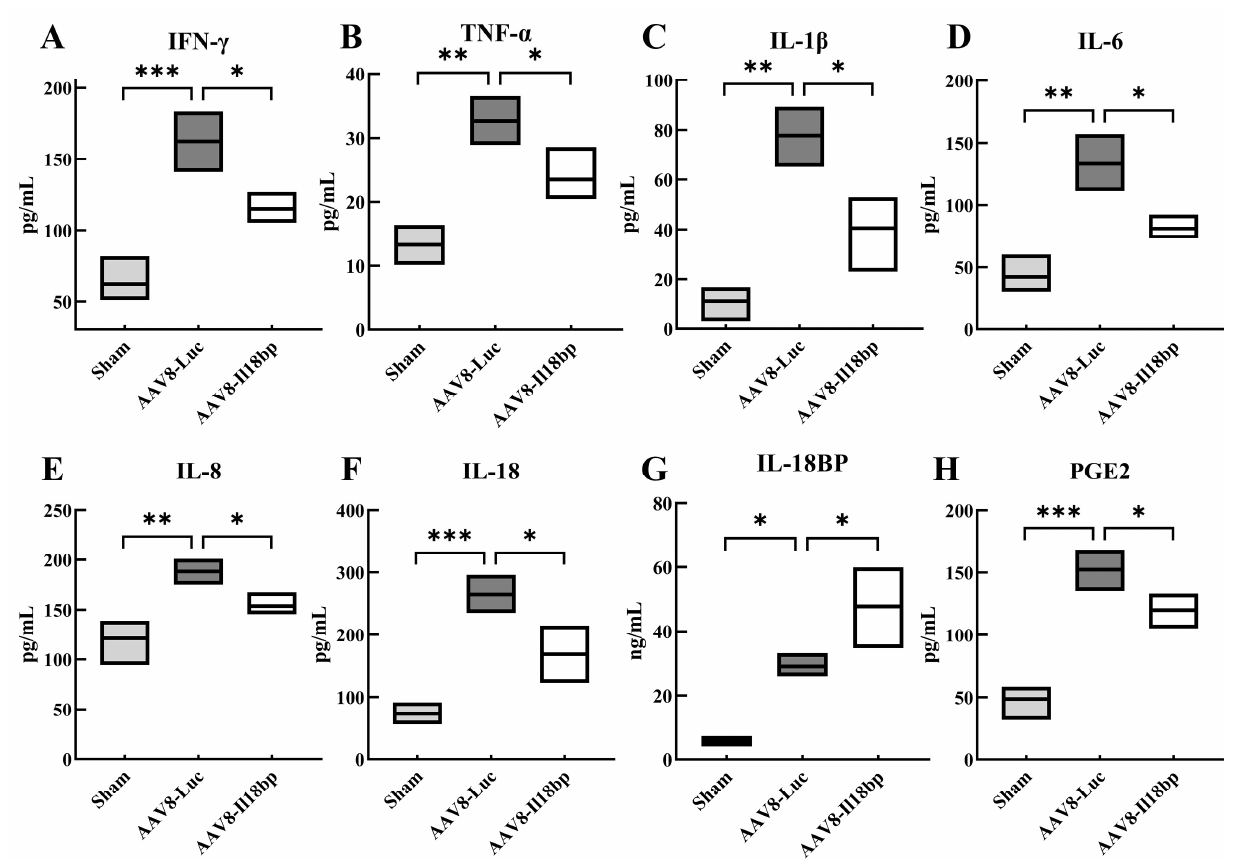
Figure 3. Serum levels of inflammatory factors in different groups. ( A – E ) Serum levels of IFN-γ, TNF-α, IL-1β, IL-6, and IL-8 in recipients whose donors were pretreated with AAV8-Luc were significantly higher than those in the sham group. However, these inflammatory factors in recipients whose donors were pretreated with AAV8-Il18bp were significantly lower than those in recipients whose donors were given AAV8-Luc. ( F ) The level of IL-18 was significantly increased after OLTx with AAV8-Luc, and infection of AAV8-Il18bp could decrease the IL-18 level in serum. ( G ) Serum level of IL-18BP was significantly increased after OLTx with AAV8-Luc. ( H ) Serum level of PGE2 was detected by ELISA. Results represent the mean ± SEM ( n = 3 per group); * p < 0.05; ** p < 0.01; *** p <